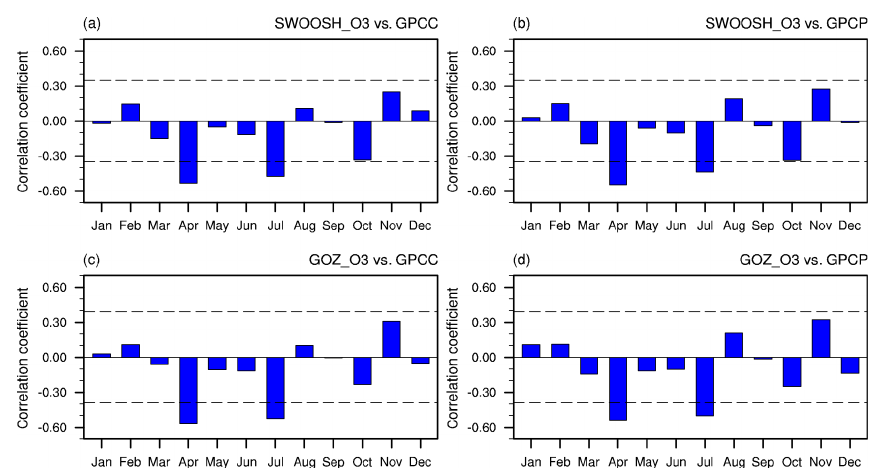
Figure 2. (a) Correlation coefficients between March ASO index and precipitation anomalies in the northwestern US (43–50 ◦ N, 115– 130 ◦ W) for each month calculated from SWOOSH (a, b) and GOZCARDS (c, d) ozone, and GPCC (a, c) and GPCP (b, d) rainfall for the period 1984–2016. The dashed black lines refer to the correlation coefficient that is significance at 95% confidence level. The long-term linear trend and seasonal cycle were removed from the original datasets before calculating the correlation